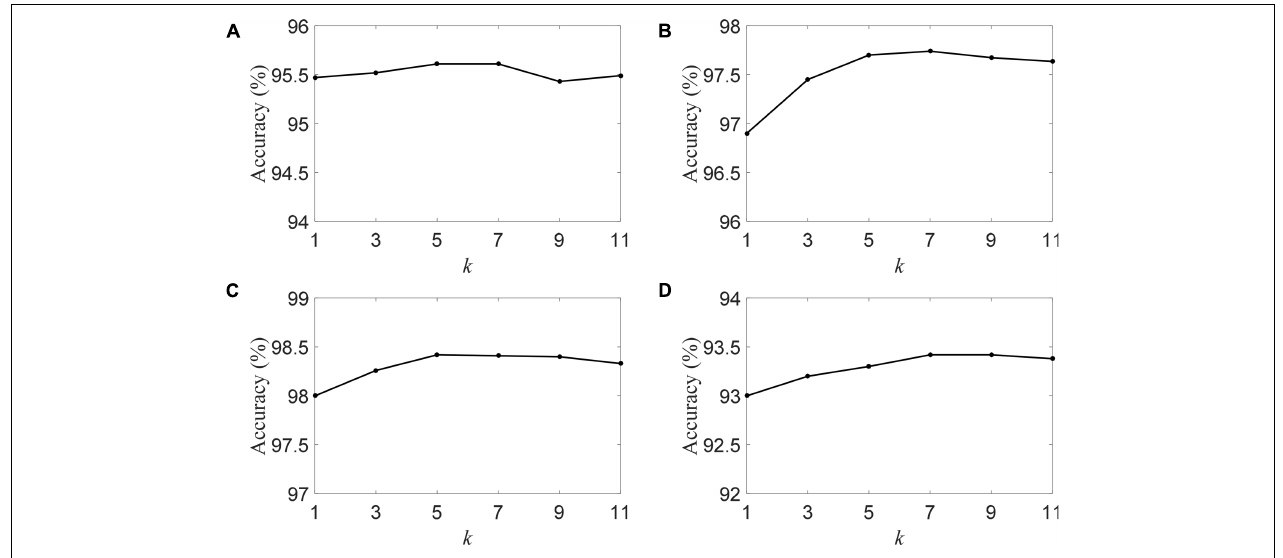
FIGURE 6 | The accuracy of the DSLRR algorithm with different k in four datasets, (A) HC and AD, (B) HC and MCI, (C) HC and (MCI+AD), and (D) MCI and